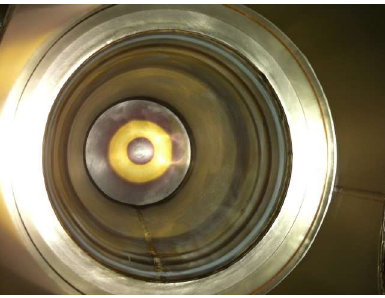
FIG. 3. Picture of the inside of the Nb susceptor can of the induction furnace showing the presence of a ‘‘gold colored’’ ring at the top after the HT at 1400 (cid:1) C .